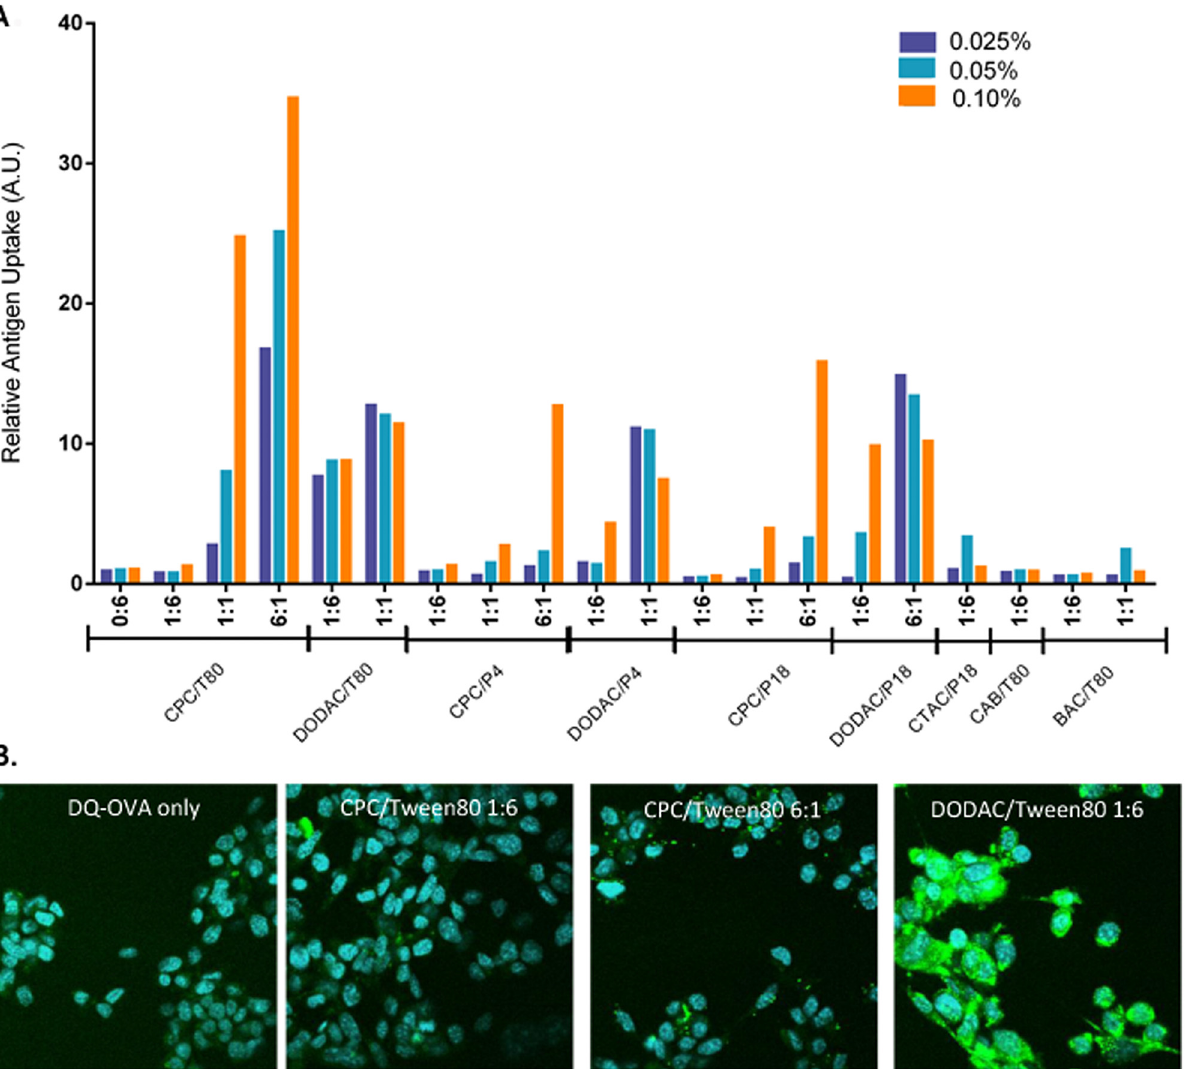
Fig 3. NE facilitated uptake of DQ-OVA in TC-1 epithelial cells. (A) TC-1 cells were incubated with the indicated NE concentrations and DQ-OVA for 2 h at 37°C. Cellular fluorescence was measured by flow cytometry. Relative antigen uptake is expressed as fold fluorescence (MFI at ex 488 nm, em 533 nm) increase relative to that of cells treated with DQ-OVA alone. Representative NE formulations with increasing cationic:nonionic surfactant ratios are shown. (B) Confocal fluorescence microscopy of TC-1 cells incubated with 10 μ g/mL of DQ-OVA alone or with 0.05% of the indicated NE for 2 h at 37°C. Nuclei were stained with DAPI (blue), intracellular and proteolytically processed DQ-OVA (green).